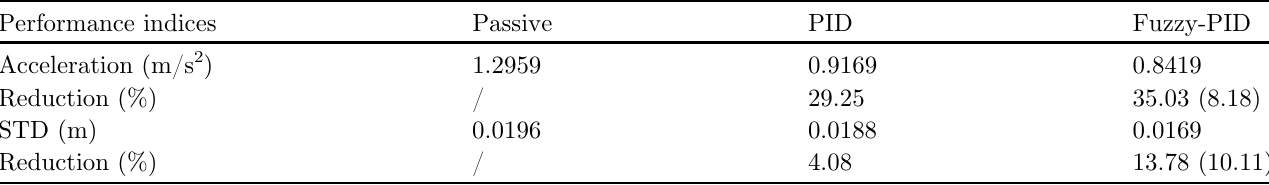
Table 8. RMS values under bump road pro fi